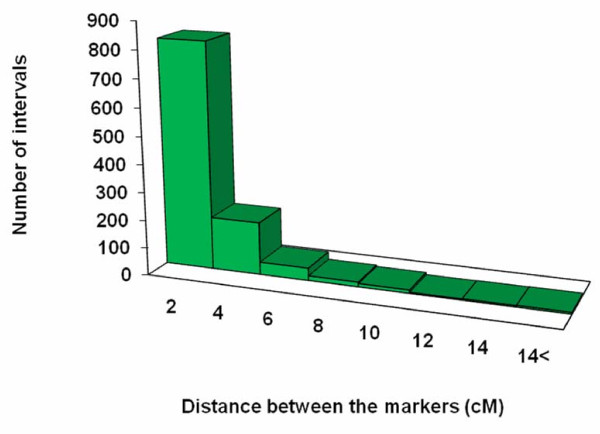
Distribution of the map distance between two adjacent mapped markers.